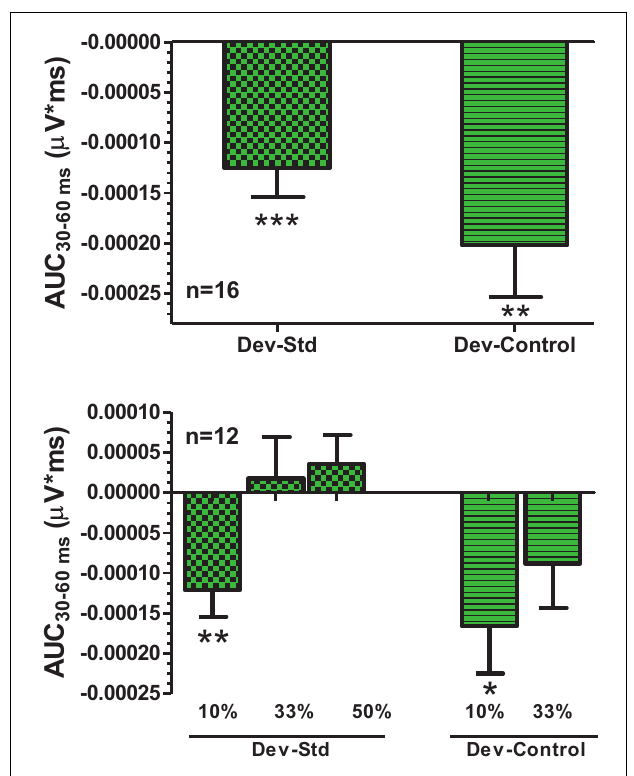
FIGURE 2 |Top panel , AUC 30–60ms areas from difference waves show robust significance against a hypothetical zero value (Bonferroni corrected P < 0.0125). Bottom panel , AUC 30–60ms was robustly sensitive to deviant probability.